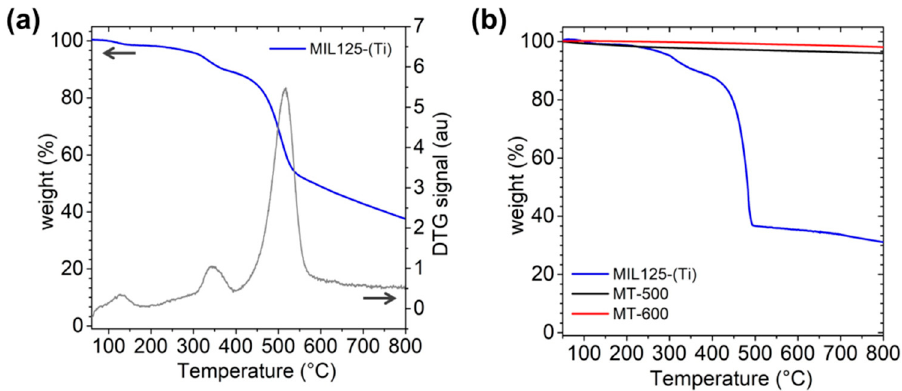
Figure 2. ( a ) TGA profile of MIL125 ‐ (Ti) in inert atmosphere (N 2 ) along the DTG signal; ( b ) TGA profiles of MIL125 ‐ (Ti), MT ‐ 500 and MT ‐ 600 in air.